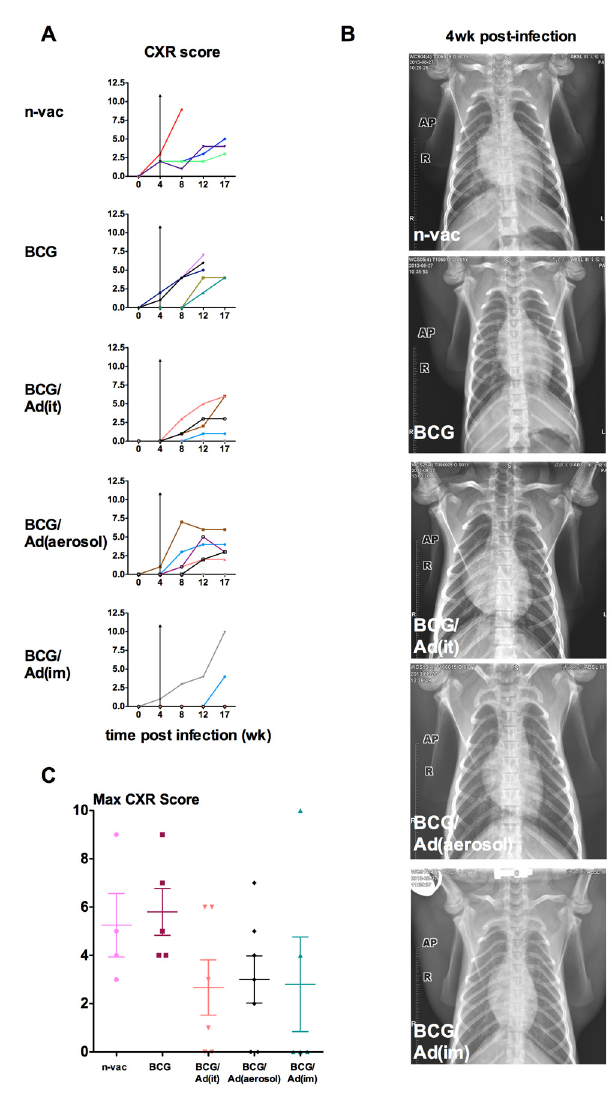
Fig 5. Longitudinal kinetics of radiological changes in the lung. Chest X-ray (CXR) was acquired by using DIGI Eye 380 by placing anesthetized animals in dorsal recumbence position. X-ray images were scored using relative scoring system. ( A ) Lines represent individual animals in each group and color assigned to individual animals in each group is kept consistent throughout the article for comparability. Wilcoxon ranked test is used to compare CXR scores post-infection relative to values before infection (0), showing mean. Vertical arrow lines in the graphs indicate the evidence of CXR changes 4 weeks post- infection in non-vaccinated na ï ve and non-boosted BCG-primed animals, but not in AdHu5Ag85A-boosted animals. ( B ) Representative radiographs of CXR of animals in each group 4 week post-infection. ( C ) Scatter dotplot depicting the mean maximum CXR scores ± standard error for animals in each group. Mann-Whitney rank test is used to compare CXR scores in vaccinated groups to na ï ve group.